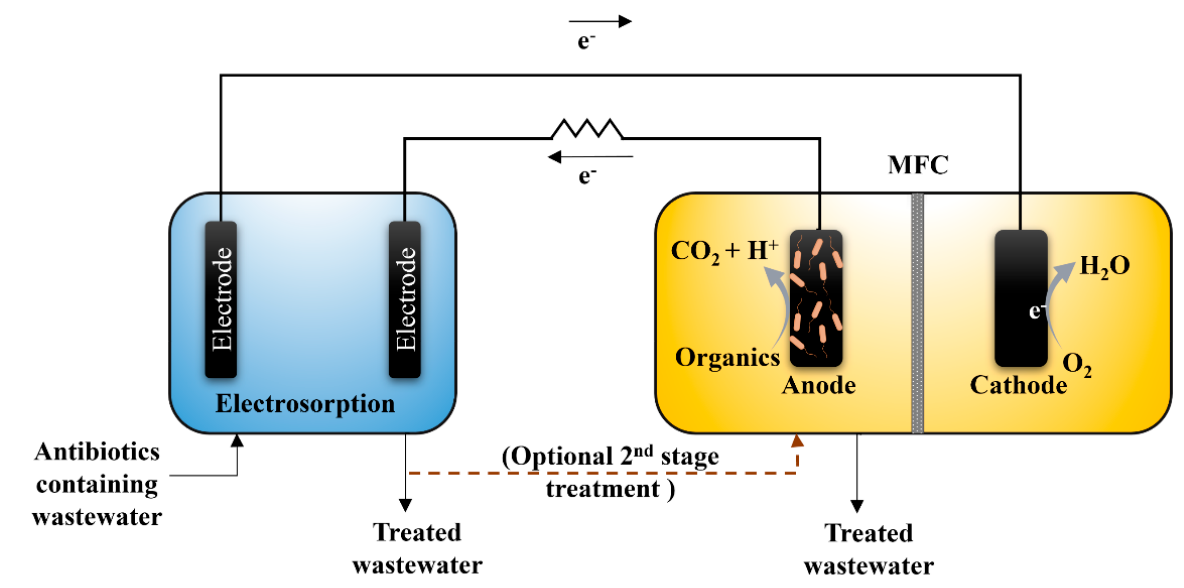
Figure 4. Schematic of hybrid process coupling electrosorption and MFCs.